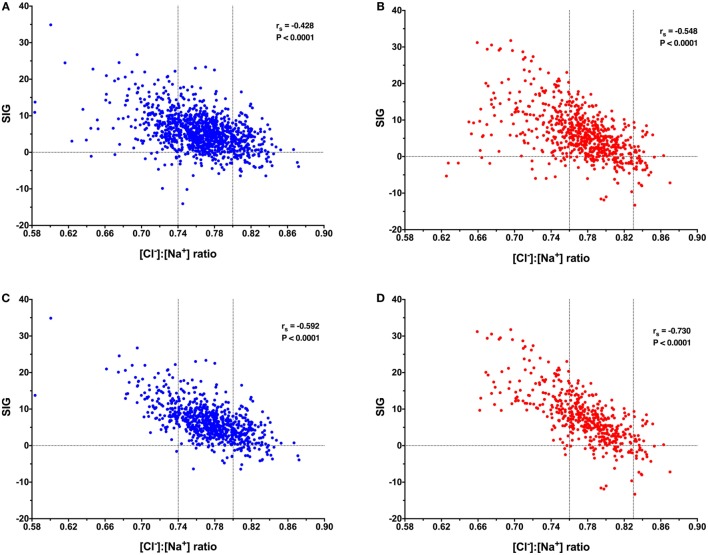
Scatterplots of canine (blue) and feline (red) [Cl−]:[Na+] ratio values against strong ion gap (SIG) values. Horizontal dotted lines indicate SIG of 0. Vertical dotted lines indicate the site-specific reference values for [Cl−]:[Na+] ratio. (A) Data from 1,106 canine blood gas and electrolyte analyses suggest a significant moderate negative correlation between [Cl−]:[Na+] ratio and SIG, Spearman’s rho (rs) −0.428, P < 0.0001. (B) Data from 671 feline blood gas and electrolyte analyses suggest a significant moderate negative correlation between [Cl−]:[Na+] ratio and SIG, rs −0.548, P < 0.0001. (C) Data from 739 canine blood gas and electrolyte analyses in patients with a metabolic acidosis (base deficit greater than 4.0) suggest a significant moderate negative correlation between [Cl−]:[Na+] ratio and SIG, rs −0.592, P < 0.0001. (D) Data from 490 feline blood gas and electrolyte analyses in patients with a metabolic acidosis (base deficit greater than 4.0) suggest a significant strong negative correlation between [Cl−]:[Na+] ratio and SIG, rs −0.730, P < 0.0001.